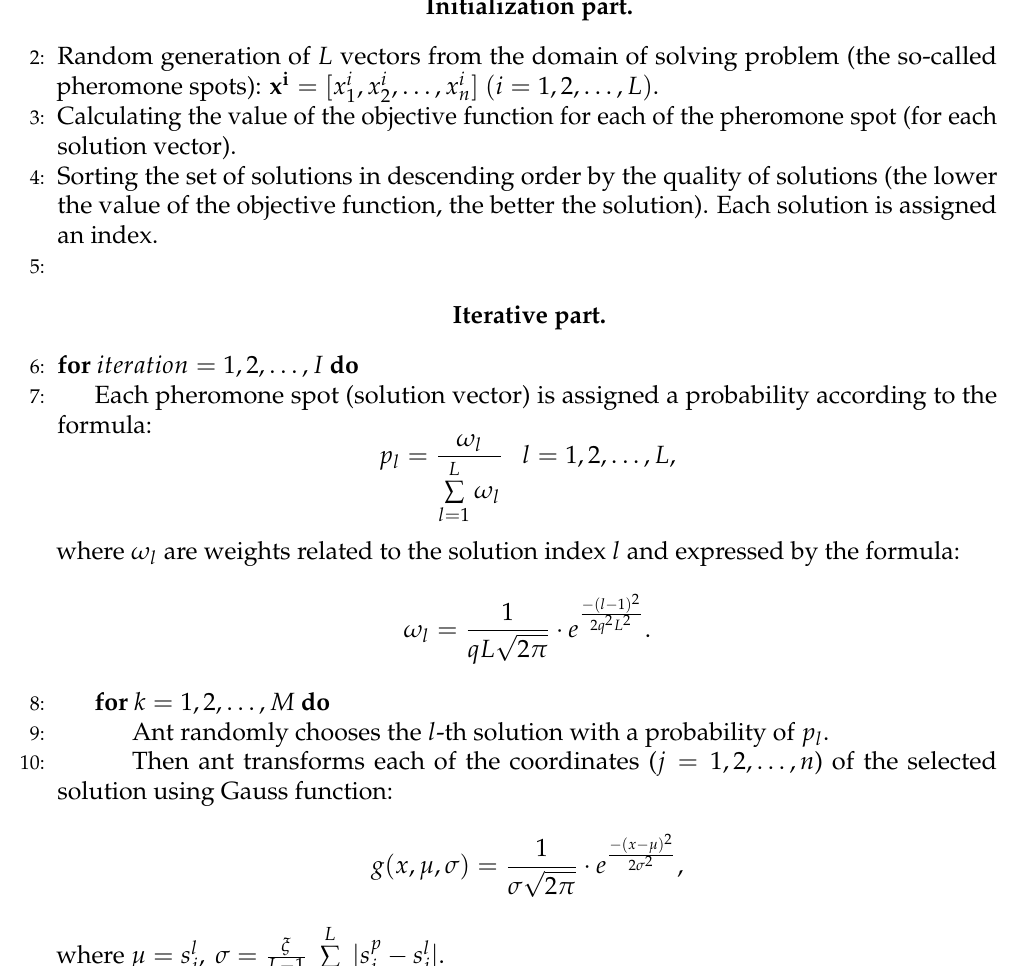
Algorithm 1 Ant Colony Optimization algorithm (ACO).